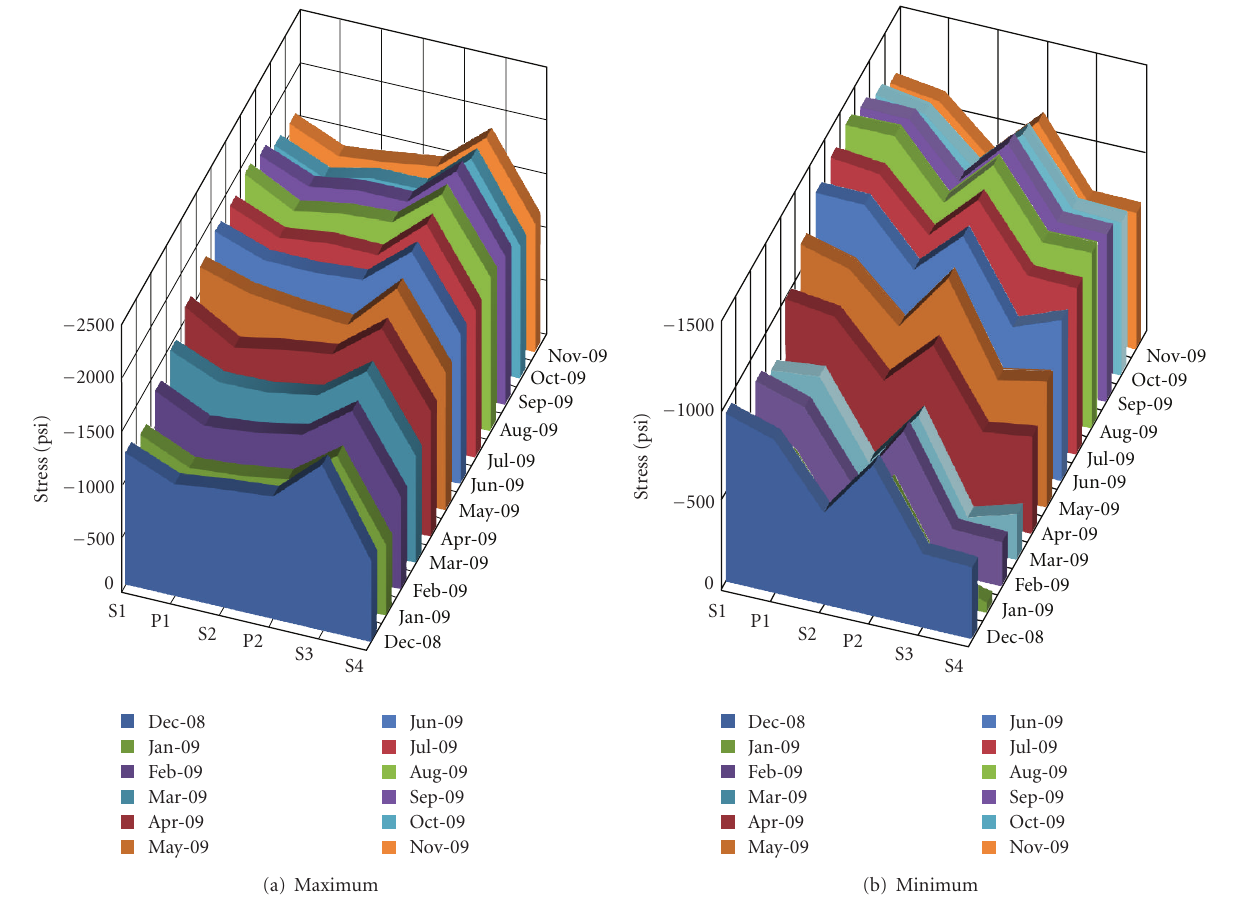
Figure 12: Maximum and minimum transverse stresses (psi)—north